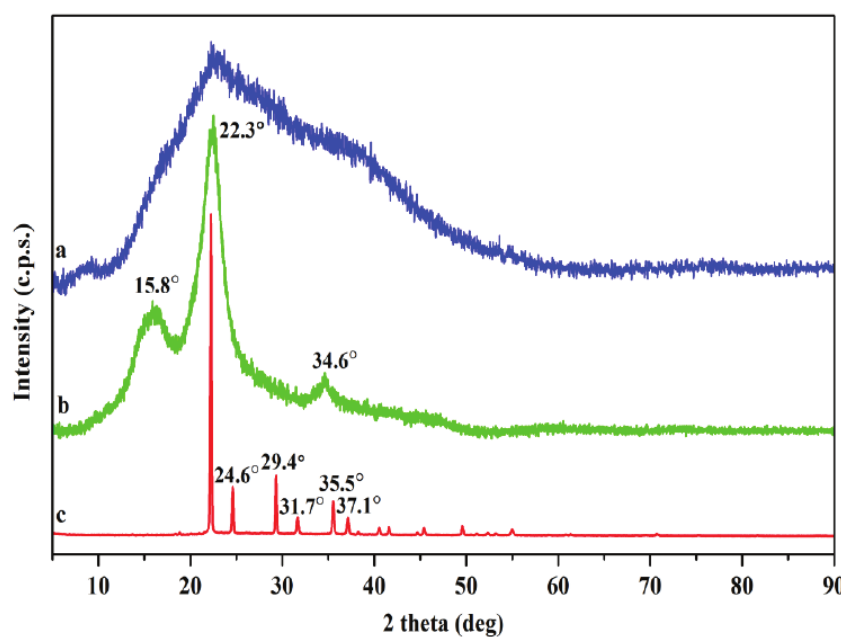
Figure 2: X-ray diffraction patterns of SC-g-PAA/PAM/Urea (a), SC (b) and urea